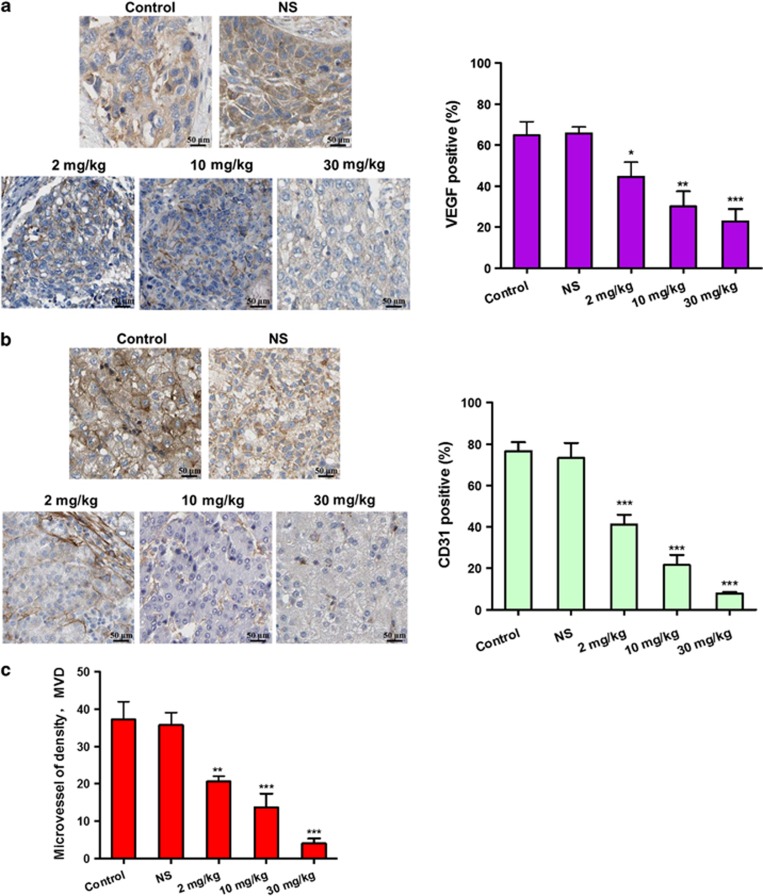
Determination of angiogenesis by immunohistochemical analysis of VEGF and CD31 expression. VEGF and CD31 protein expression was significantly downregulated in PANC-1 tumors. (a) Immunohistochemical staining of VEGF in xenograft tumors of each of the indicated control and mogroside V treatment groups. (b) Representative images of CD31 immunohistochemical staining in xenograft tumors of each of the indicated control and mogroside V treatment groups. (c) Graph of the MVD measurements in sections of xenograft tumors as determined by CD31 expression. The data represent the means±s.d. Statistical analysis was performed using the Student's t-test. *P<0.05, **P<0.01 and ***P<0.001 versus the control values.